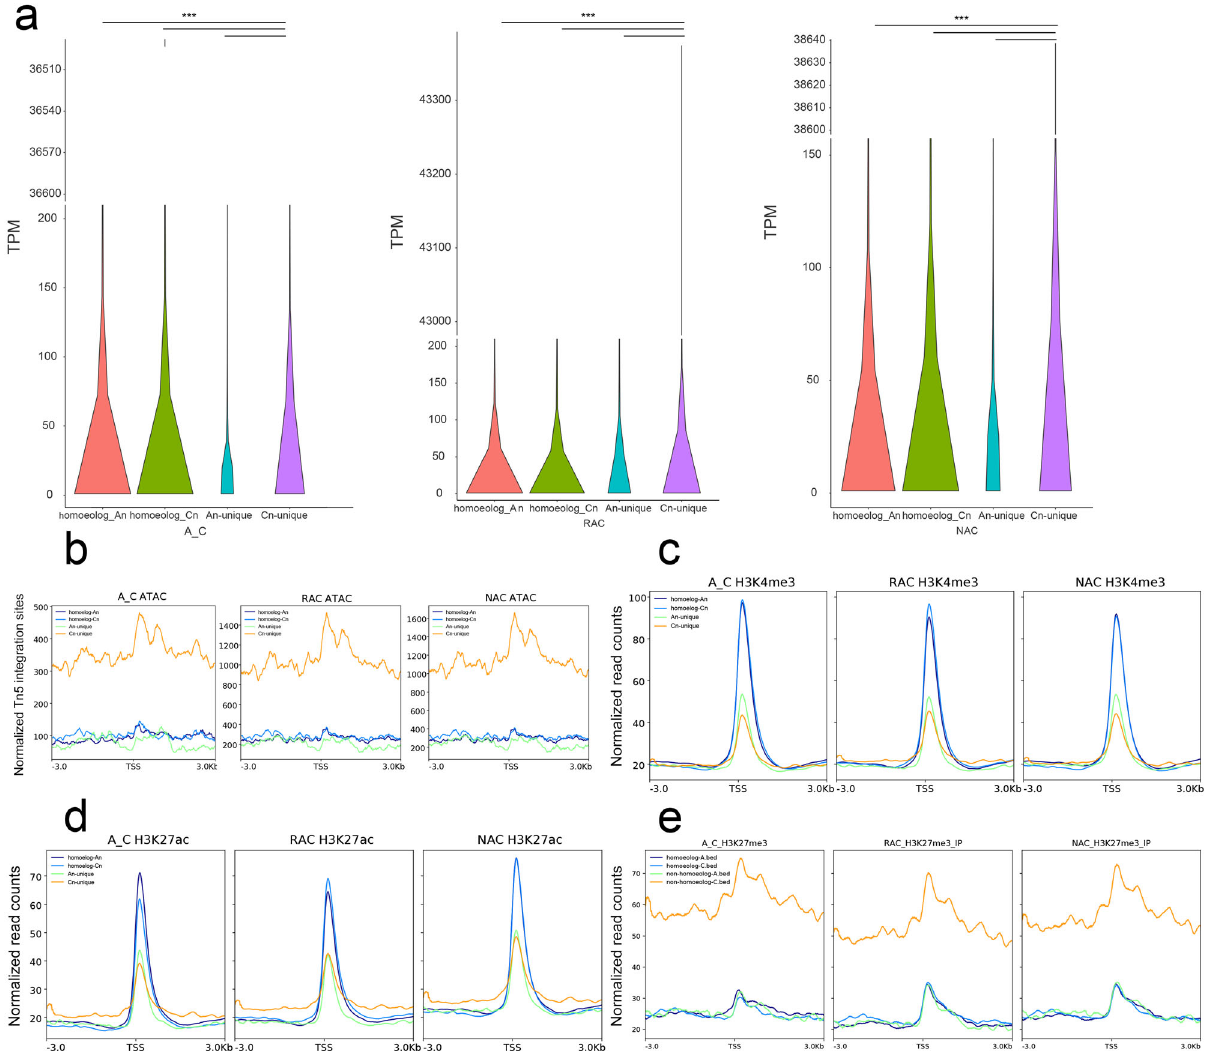
Fig. 8 Comparison of gene expression levels and four epigenetic modi fi cations among homeologous genes and subgenome-unique genes in two subgenomes. a Gene expression levels of homeologous genes and subgenome-unique genes in the two subgenomes. b Chromatin accessibility of homeologous genes and subgenome-unique genes in two subgenomes. c H3K4me3 level of homeologous genes and subgenome-unique genes in two subgenomes. d H3K27ac level of homeologous genes and subgenome-unique genes in two subgenomes. e H3K27me3 level of homeologous genes and subgenome-unique genes in two subgenomes. A_C, in silico ‘ hybrid ’ ; RAC, resynthesized B. napus ; NAC, natural B. napus ; TSS, transcriptional start